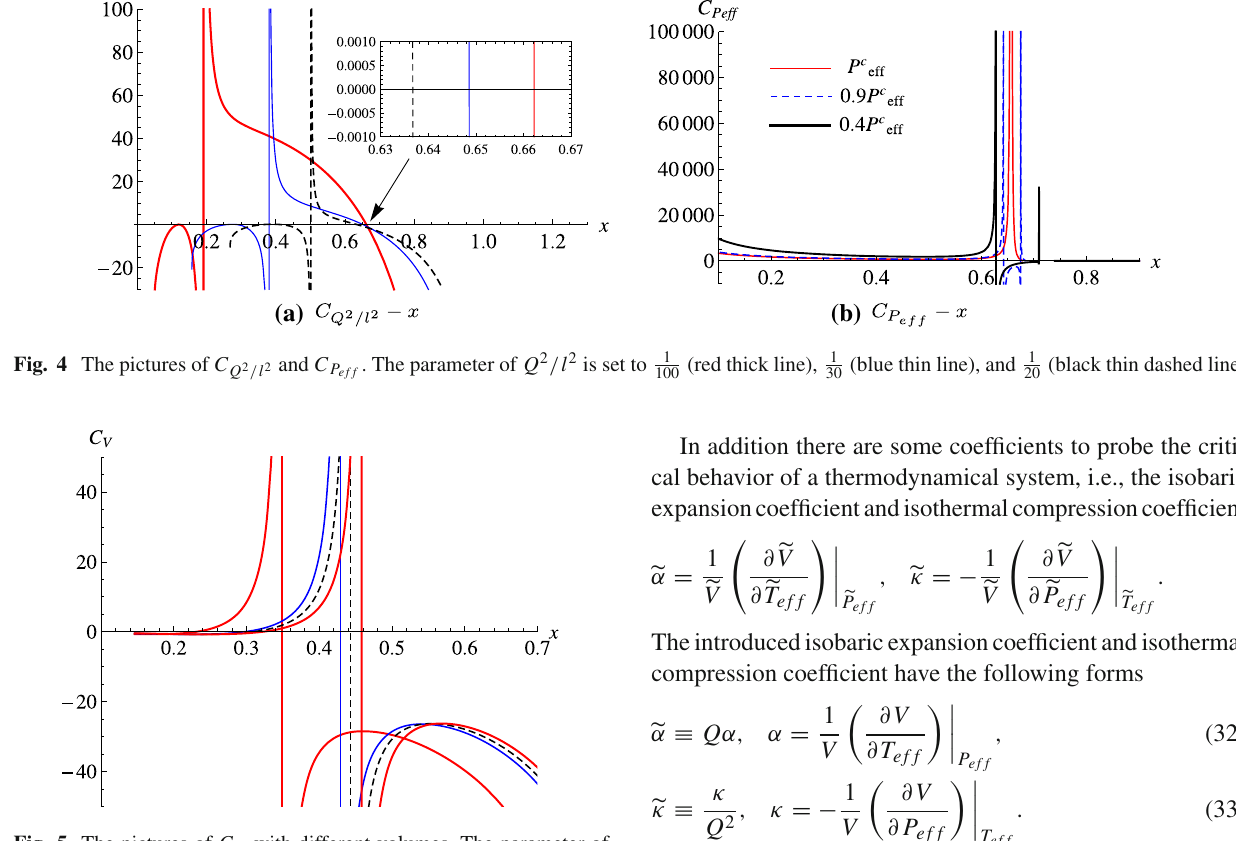
Fig. 5 The pictures of C V with different volumes. The parameter of V is set to V c (red thick line), 0 . 9 V c (blue thin line), and 0 . 5 V c (black thin dashed